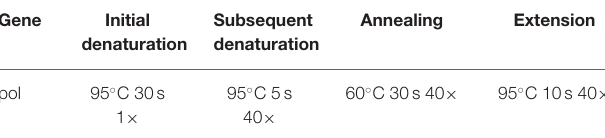
TABLE 4 | The protocol in qRT-PCR reaction.